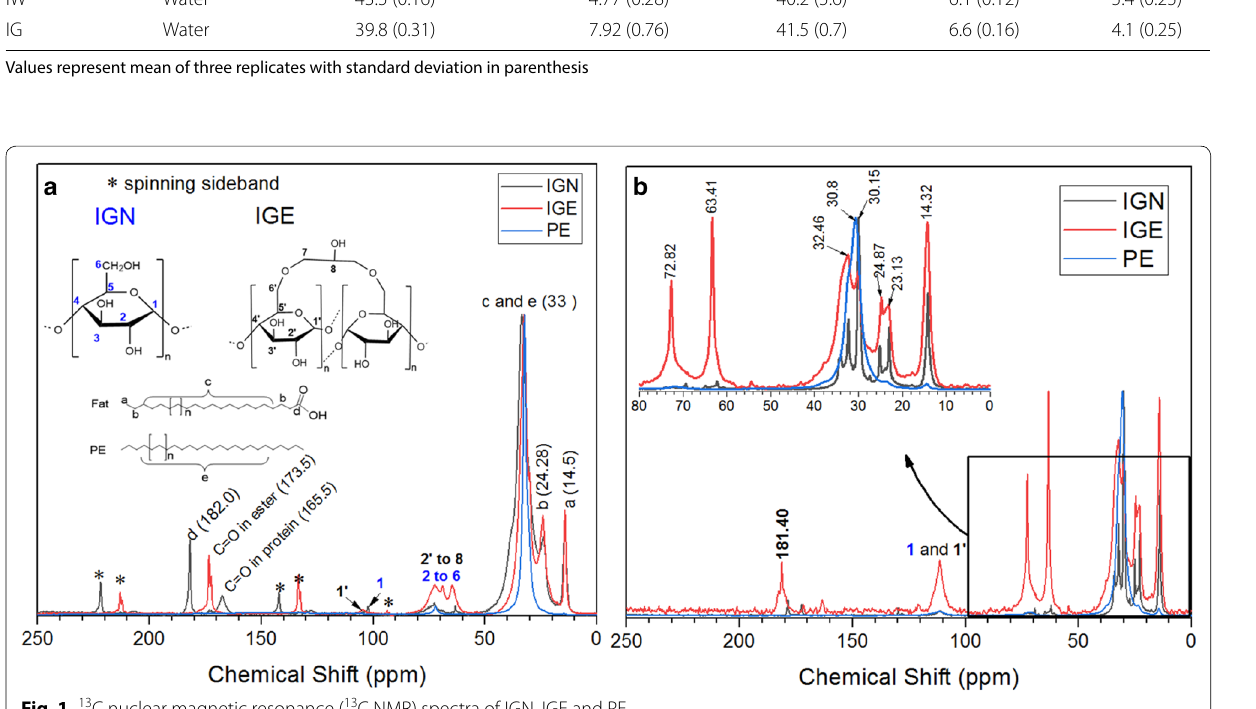
Fig. 1 13 C nuclear magnetic resonance ( 13 C NMR) spectra of IGN, IGE and